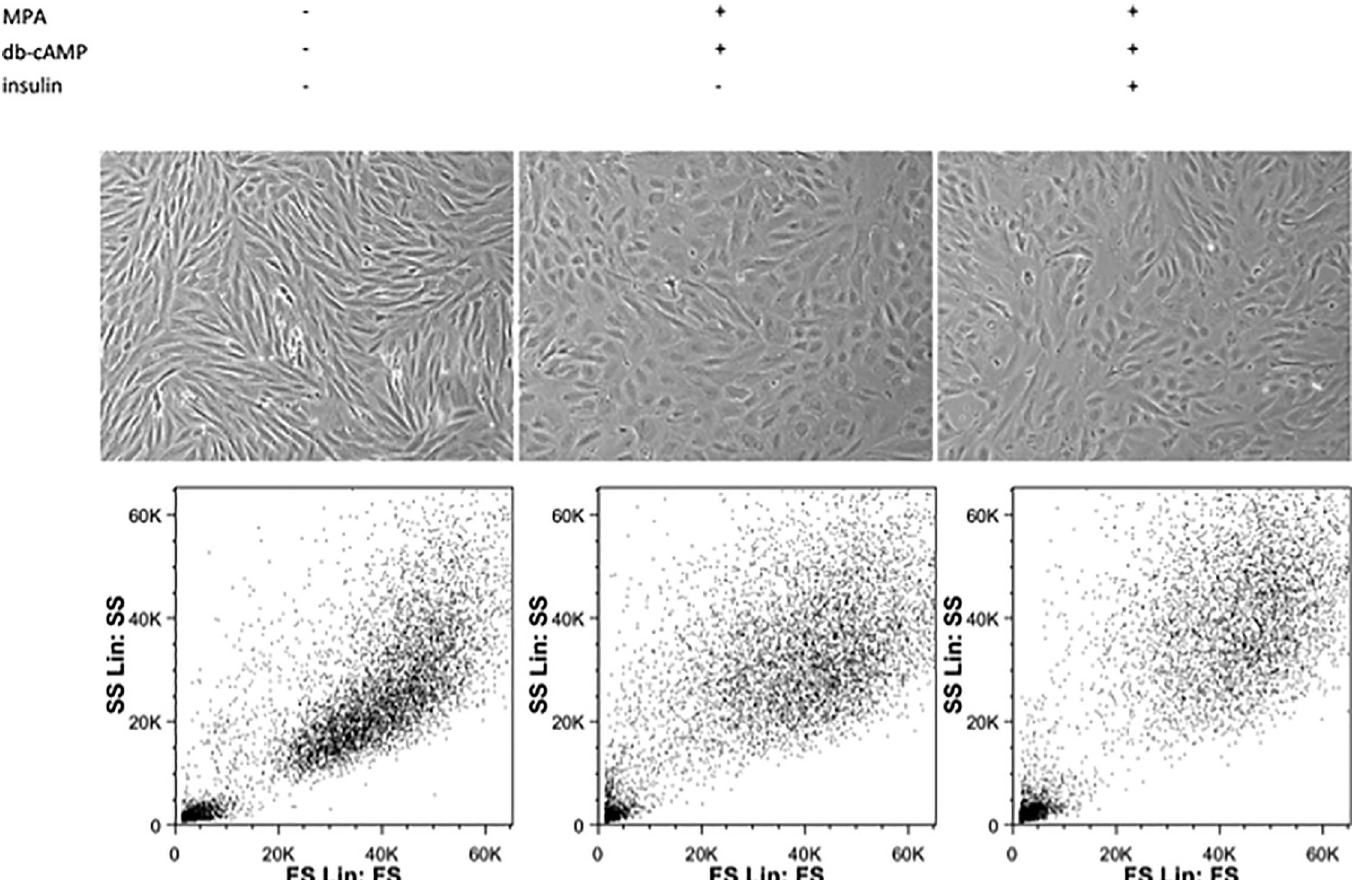
Fig 2. Micrographs and forward and side scatter analysis of undifferentiated stromal and decidualized cells in the absence or presence of insulin. Representative micrographsof undifferentiated stromal and decidualized cells (MPA + db-cAMP) in the absenceor presence of insulinwere taken using an inverted microscope with 40x magnification. Forward vs side scatter (FCS/SSC) dot plot generatedby flow cytometer showingthe cell distribution of undifferentiated stromal and decidualizedcells in the absenceor presenceof insulin.